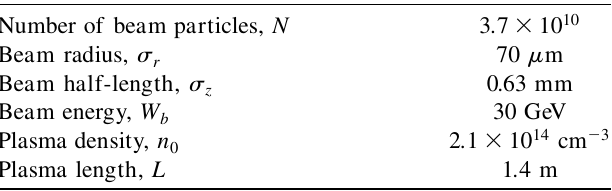
TABLE I. Beam and plasma parameters.